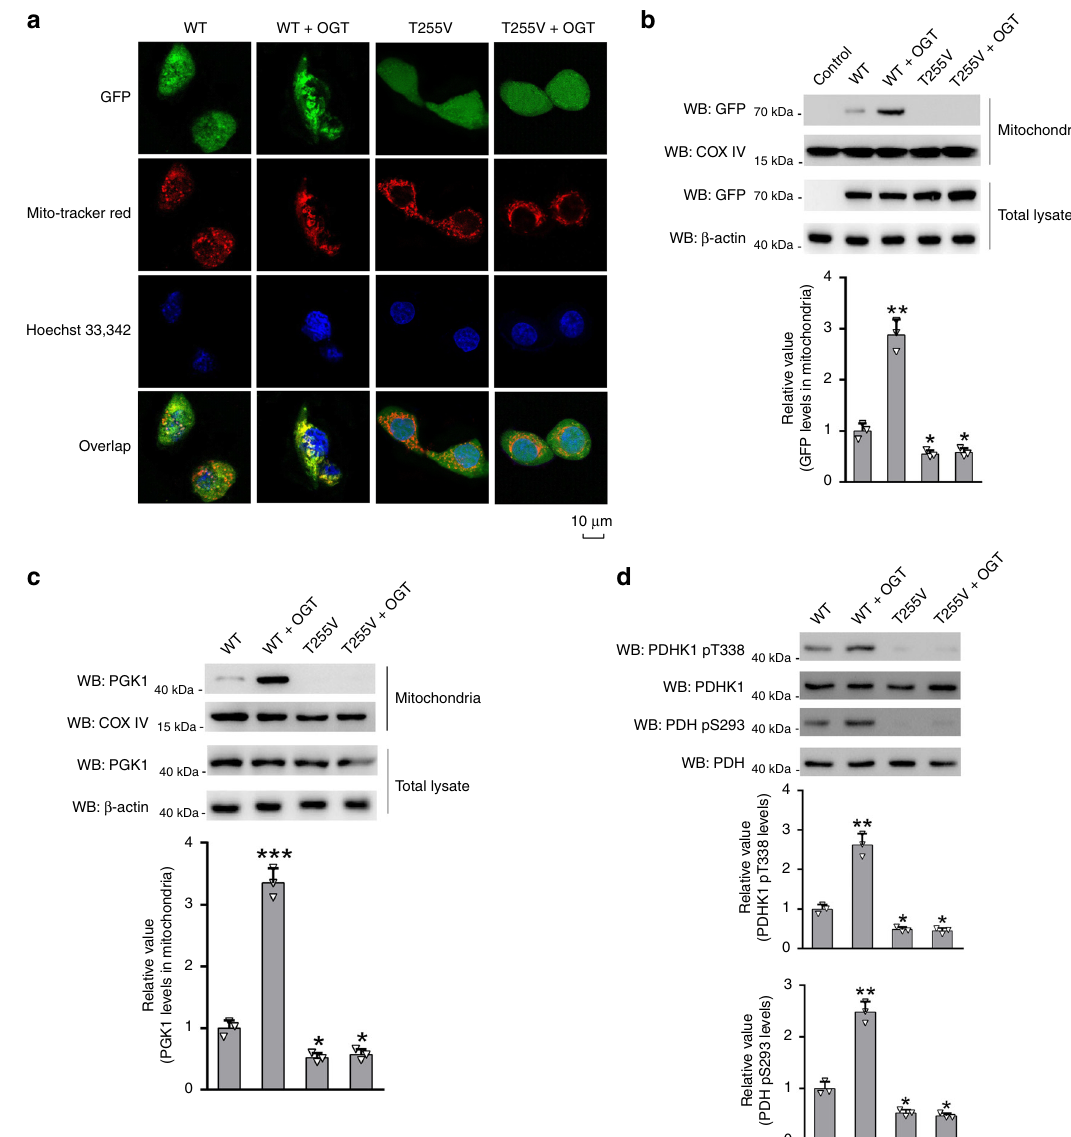
Fig. 5 T255 O-GlcNAcylation induces the mitochondrial translocation of PGK1. a Cellular distribution of PGK1 as determined by immunostaining in the presence or absence of OGT overexpression. HT-29 cells were transfected with GFP-fused PGK1 WT or T255V construct. Cells were co-stained with MitoTracker red, a fl uorescent marker for mitochondria. b , c Immunoblotting analysis of cellular distribution of PGK1 WT or T255V in the presence or absence of OGT overexpression. d Immunoblotting analysis of PDHK1 and PDH phosphorylation in mitochondria. Mitochondrial fractions were prepared and immunoblotted with indicated antibodies. Total cell lysates were used as a control. Error bars denote the means± standard deviations (SD). Statistical analyses were performed by one-way analysis of variance (ANOVA) followed by Tukey ’ s post hoc test (* P < 0.05, ** P < 0.01, *** P < 0.001). Source data are provided as a Source Date fi